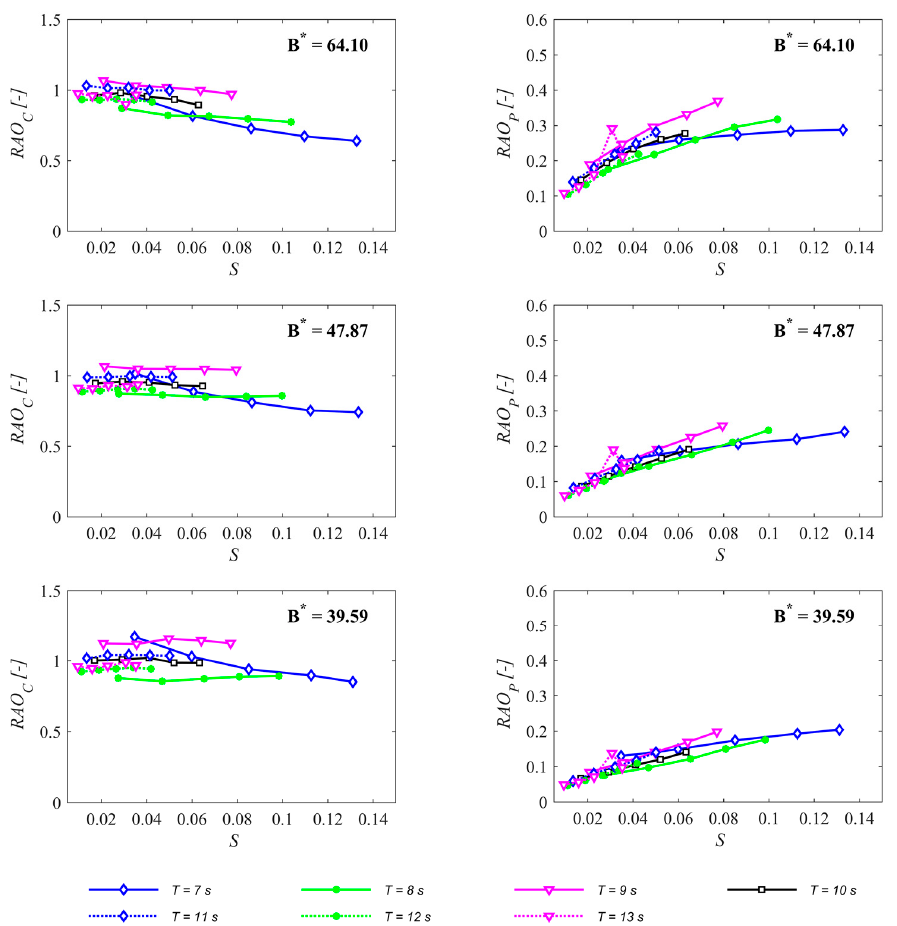
Figure 12. Variation of the response amplitude operator (RAO) for the free surface elevation and the differential pressure between inside the OWC chamber and the atmosphere ( RAO C and RAO P respectively) with the wave steepness ( S ) for regular waves (Series A): and for different values of the wave period ( T ) and damping coefficient ( B * ) (prototype data).